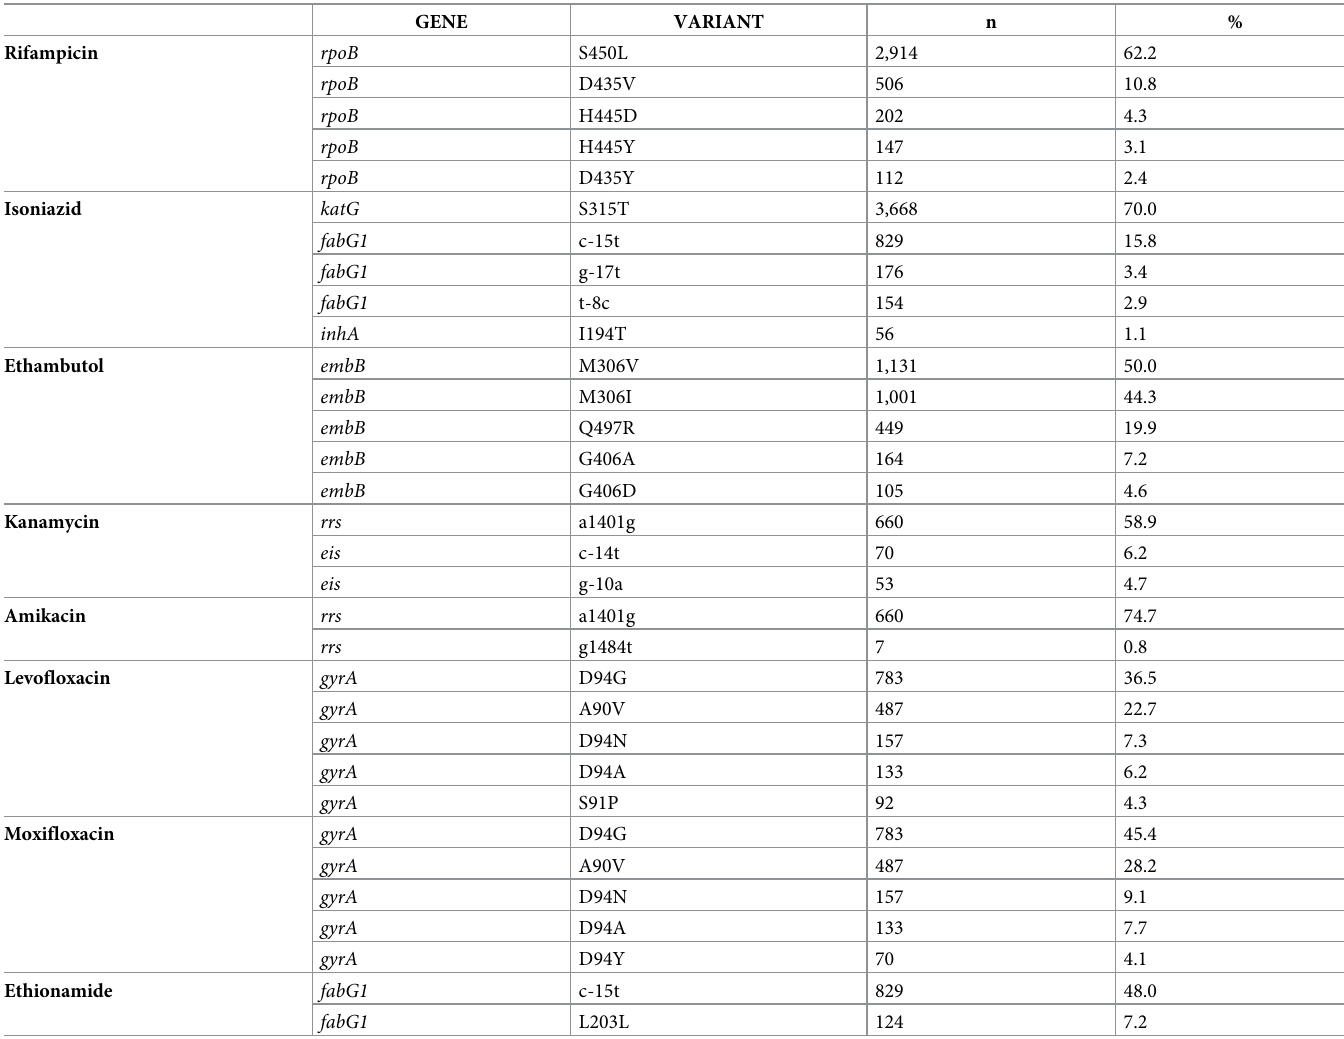
Table 3. The top mutations associated with phenotypic drug